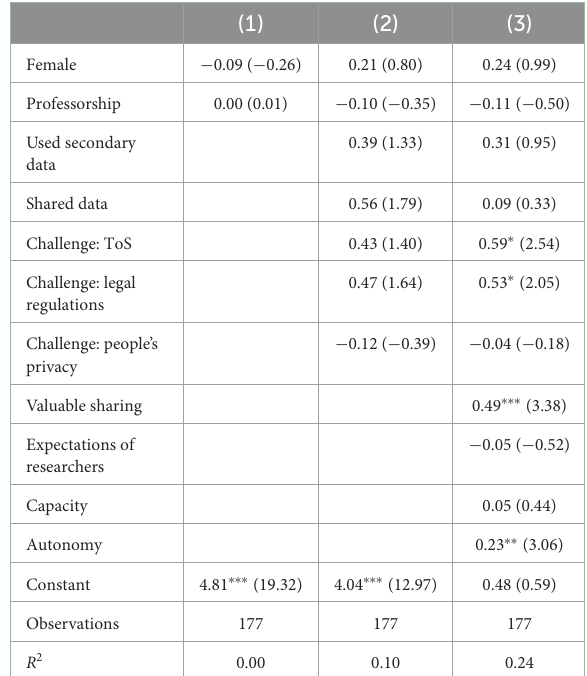
TABLE 3 Regression model to predict the intention to share data upon personal